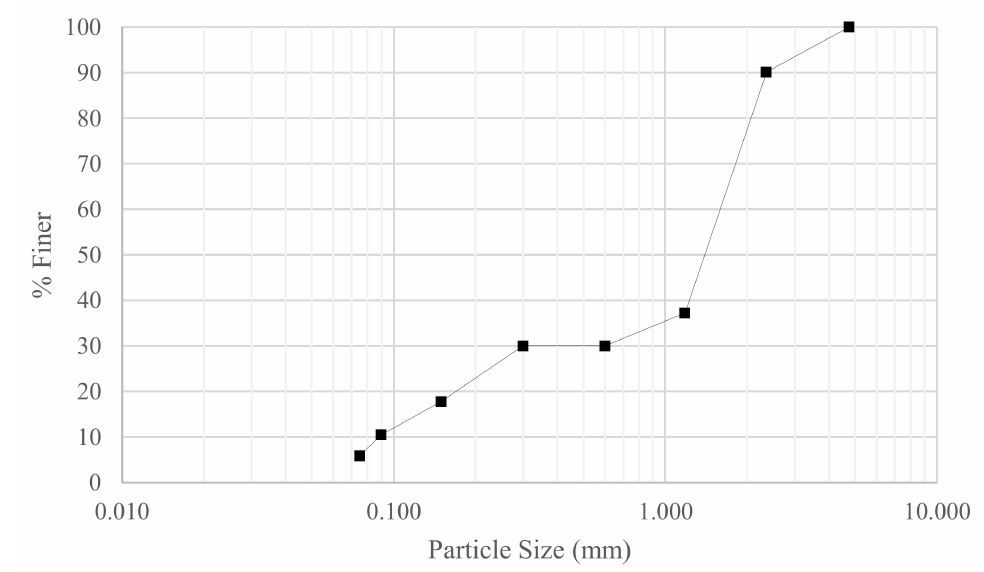
Figure 1. Particle size